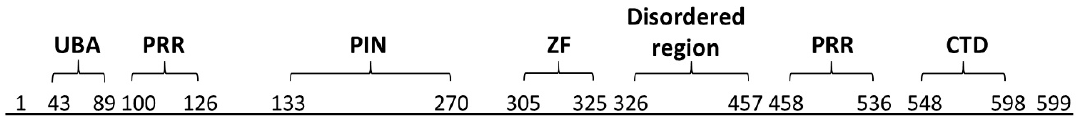
Domains of Figure 2. Domains of MCPIP1. Ubiquitin-associated domain (UBA) 43–89; proline-rich region (PRR) 100–126 and 458–536; PilT N-terminus nuclease domain (PIN) 133–270; zinc-finger motif (ZF) 305–